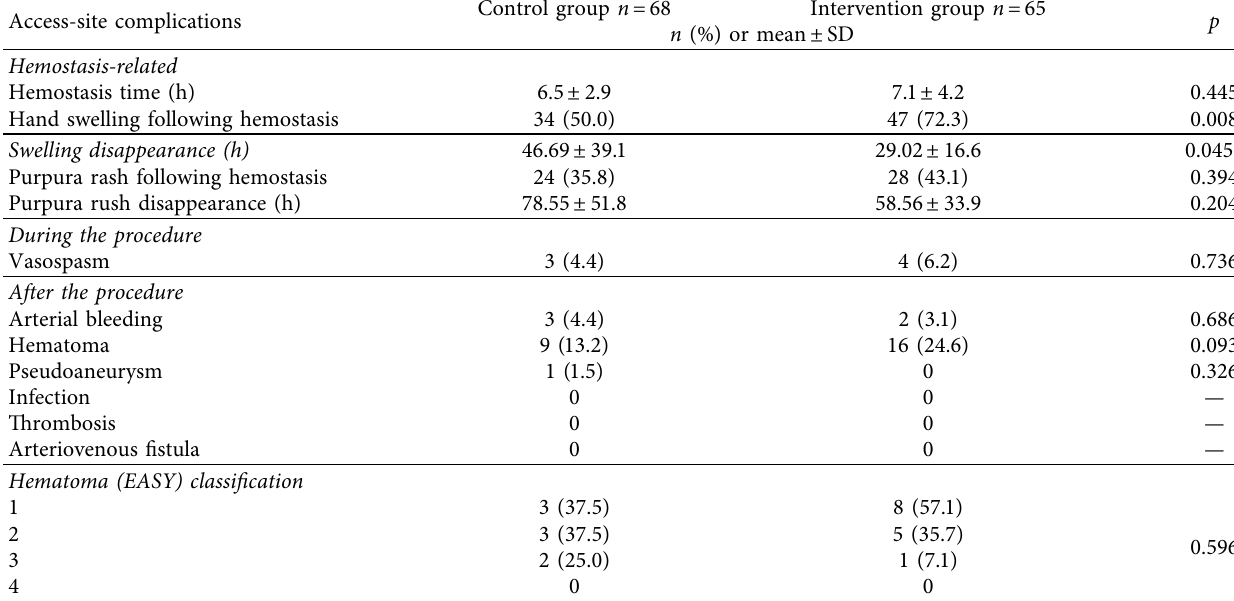
Table 3: The access-site complication distribution between